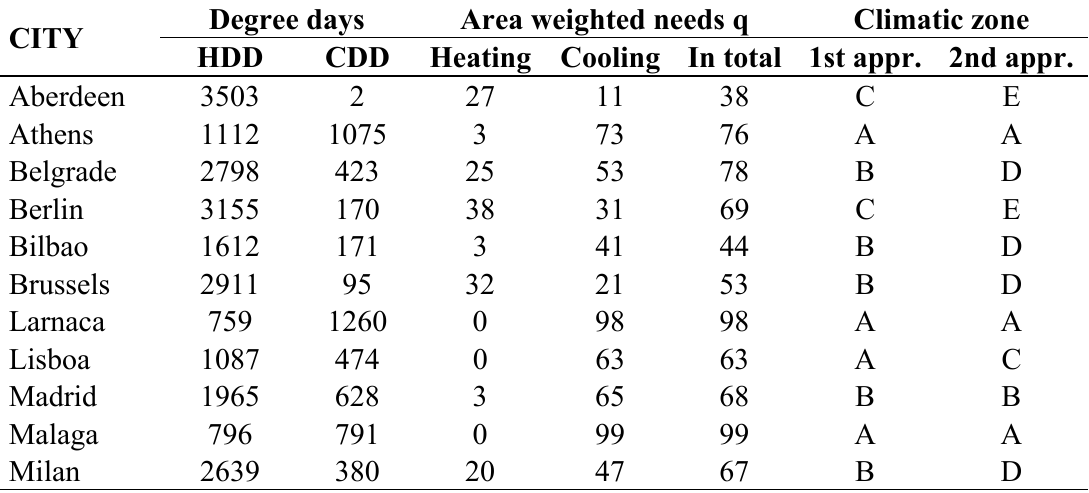
Table 3. The heating and cooling degree days, the area weighted needs calculated for heating and cooling, as well as the zone classification according to the two approaches for each